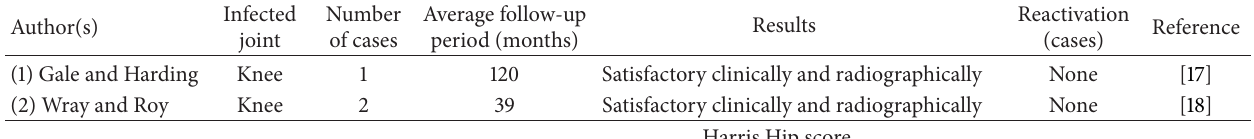
Table 1: Summary of the reports of immediate arthroplasty for active TB arthritis in the hip and knee.